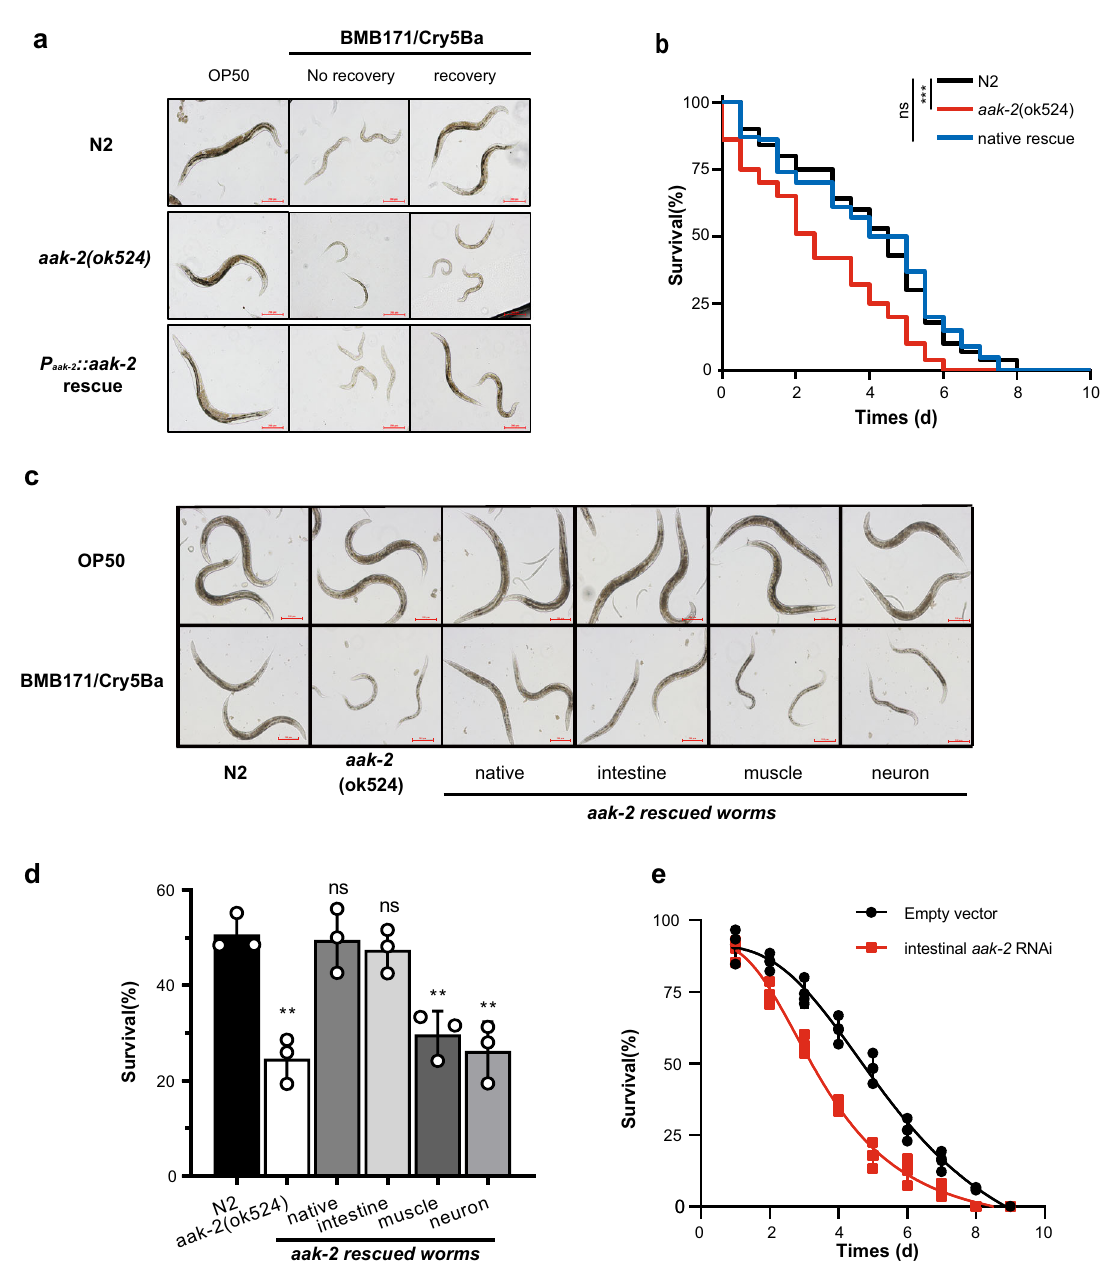
Fig. 6 AMPK activity in the intestine is required for C. elegans resistance to Bt infection. a Growth assay of C. elegans N2, aak-2(ok524), and P aak-2 :: aak-2 rescued worms after fed with OP50 or BMB171/Cry5Ba for 30 min and then recovered on an E. coli OP50 NGM plate for 24 h or not. Representative images of worms in each condition are shown. Scale bar represents 200 μ m. N = 3 independent experiments. b The survival assay of the C. elegans N2, aak- 2 ( ok524 ), and P aak-2 :: aak-2 rescue worms after being treated by BMB171/Cry5Ba ( n = 50). Data were Kaplan – Meier analyzed followed by log-rank test. c The growth assay of the C. elegans N2, aak-2(ok524), and several kinds of rescue worms after being fed with OP50 or BMB171/Cry5Ba for 3 days. Representative images of worms in each condition are shown. Scale bar represents 100 μ m. N = 3 independent experiments. d The survival of wild-type N2, aak-2(ok524) and several kinds of rescued worms after BMB171/Cry5Ba infection for 96 h. N = 3 independent experiments. e The survival of N2 worms after BMB171/Cry5Ba infection without or with intestinal aak-2 RNAi. At least 30 worms were used in each repeat. N = 3 independent experiments. Data points represent the mean values of three independent replicates, error bars denote the SD in ( d ) and ( e ). The p -value was determined by a Student ’ s t -test (Welch ’ s correction for unequal variances), *** p < 0.001, ** p < 0.01, * p < 0.05 and ns indicates no signi fi cant